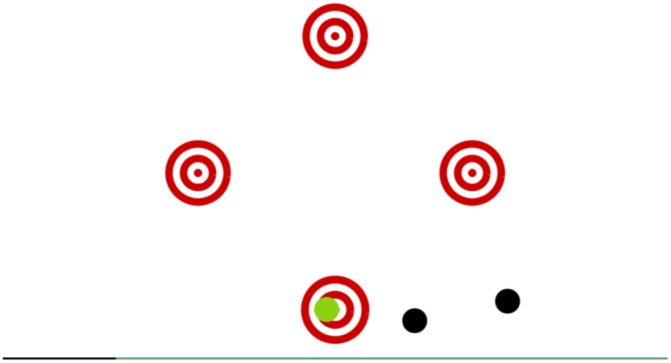
The game Targets which helps training reaction time (speed and accuracy).